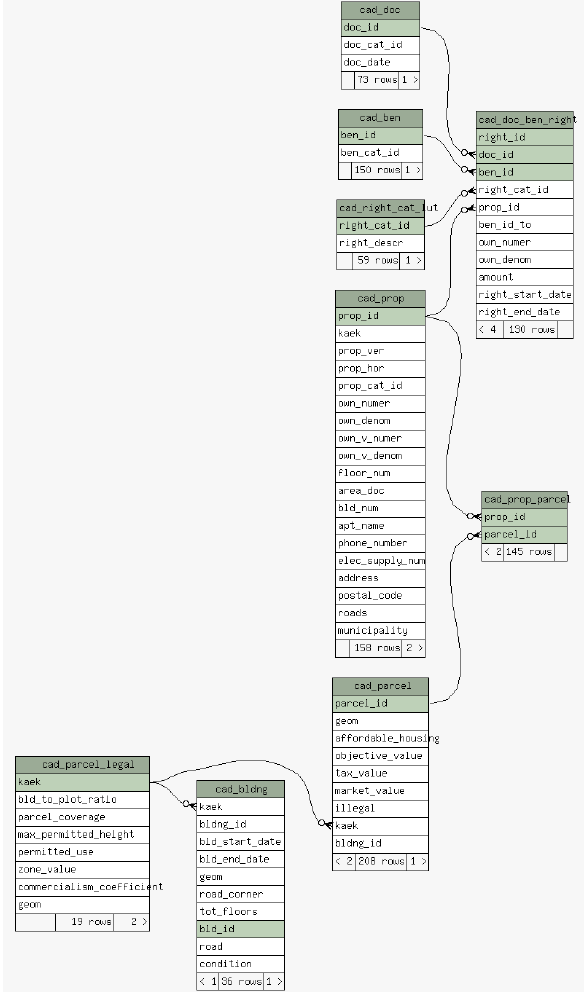
Figure 11. External database scheme including the